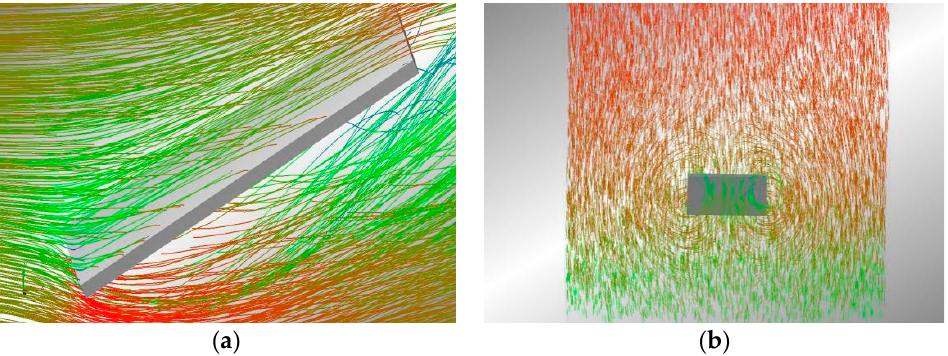
Figure 6. Movement of dust particles with particle size of 10 µ m around the solar panel, u ∗ = 0.25 ms − 1 , K = 0.5 × 10 6 Jm − 3 . ( a ) Side view. ( b ) Back view.